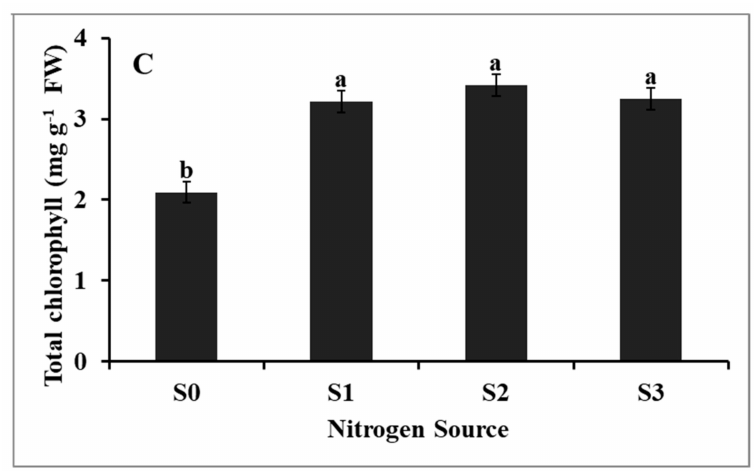
Figure 2. Average e ff ect of drip irrigation regime ( B ), N source ( C ) and their interaction ( A ) on the total chlorophyll (mg g − 1 FW) of potato. G 1 = 120% ETc irrigation; G 2 = 100% ETc irrigation; G 3 = 80% ETc irrigation; S 0 = Unfertilized (control); S 1 = Urea; S 2 = Ammonium nitrate; S 3 = Ammonium sulfate; and Error bars = Standard error of means (SEM). Values for the same parameter without a common letter were significantly di ff ered ( P > 0.05).